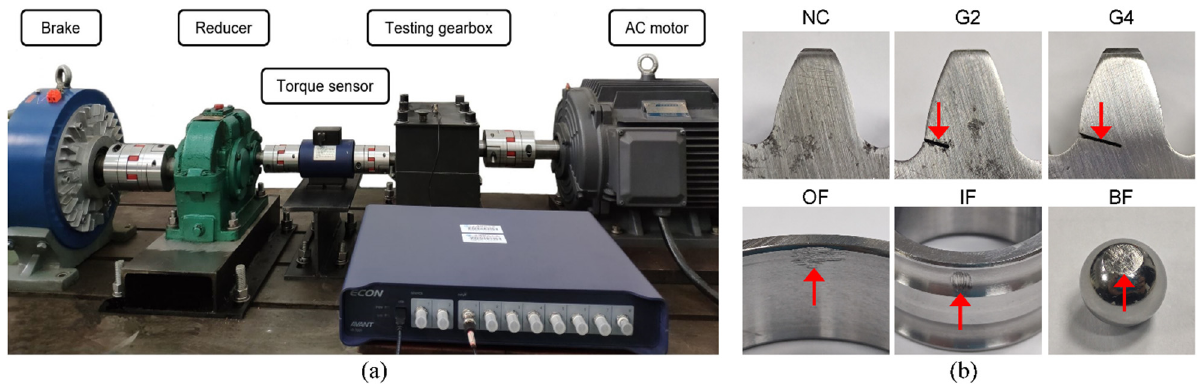
Figure 3. Experiment setup: ( a ) the gearbox testing rig, ( b ) artificial damages (arrows were used to point out the position of damages).